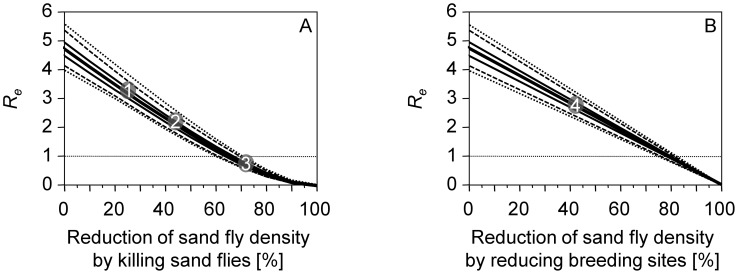
Comparison of calculated thresholds and observed reductions in sand fly density.
Re estimates that depend on a reduction of sand fly density by reducing the sand flies' life expectancy (A) or their breeding site capacity (B) are represented by minimum and maximum (dotted lines), 2.5% and 97.5% quantiles (dashed lines), quartiles (thin lines) and median (bold line). Baseline sand fly density reflects the situation in the KALANET study without control measures. Observed effects of long lasting insecticidal nets (circles 1 and 2), indoor residual spraying (circle 3) and environmental management (circle 4) on the sand fly density, as reported in two recent cluster randomised controlled trials [23], [24], are displayed as grey circles.